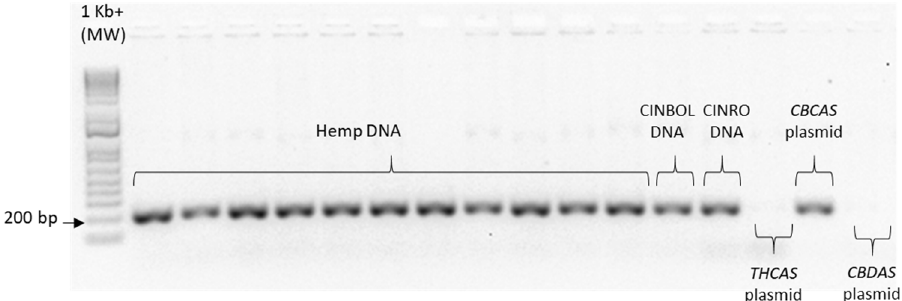
Figure A2. Specificity of primers for THCAS . The expected amplification band of 198 bp was ob- tained from pJET1.2 containing the THCAS and DNA of CINRO and CINBOL. Amplification was not obtained from pJET1.2 plasmid containing the CBCAS , and the CBDAS , and neither using DNA from hemp varieties as template.